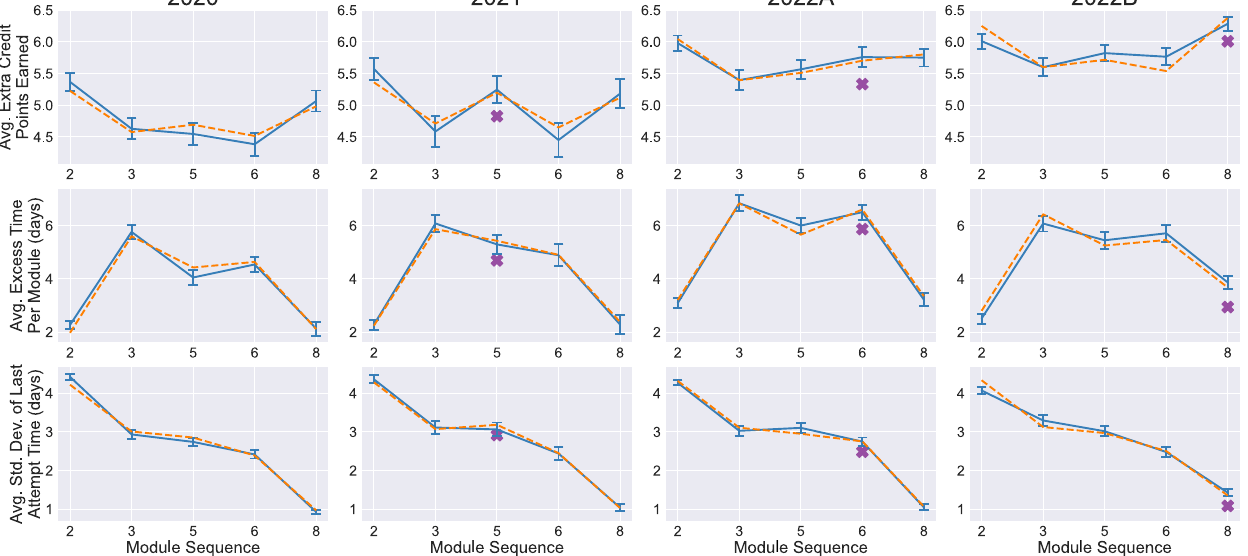
FIG. 1. Observed and modeled work distribution metrics. Blue lines indicate observed averages, with error bars for 1 standard error of the mean. Orange dotted lines show the modeled values from Eq. (1). Purple crosses show the model ’ s prediction of each metric if the planning-prompt intervention had not been implemented ð β T T ≡ 0 Þ . The gap between the orange dotted line and the purple cross thus indicates the estimated effect size. The purple marks appear only for sequences that received the intervention, which sequence this is differs by class